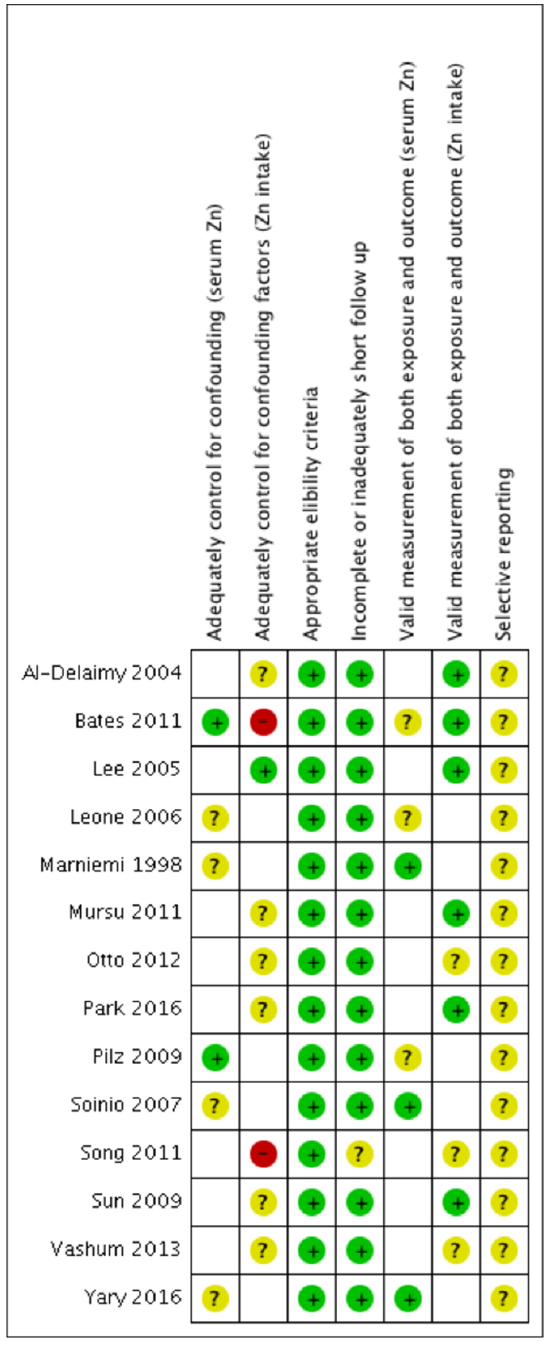
Figure 2. Summary of the risk of biases from each included study. Green (+) symbols represent low risk of bias for the specific criteria within that study. Yellow (?) symbols represent unclear risk of bias and red ( − ) symbols denote high risk of bias. Support for judgments is presented in Tables S3–S7.